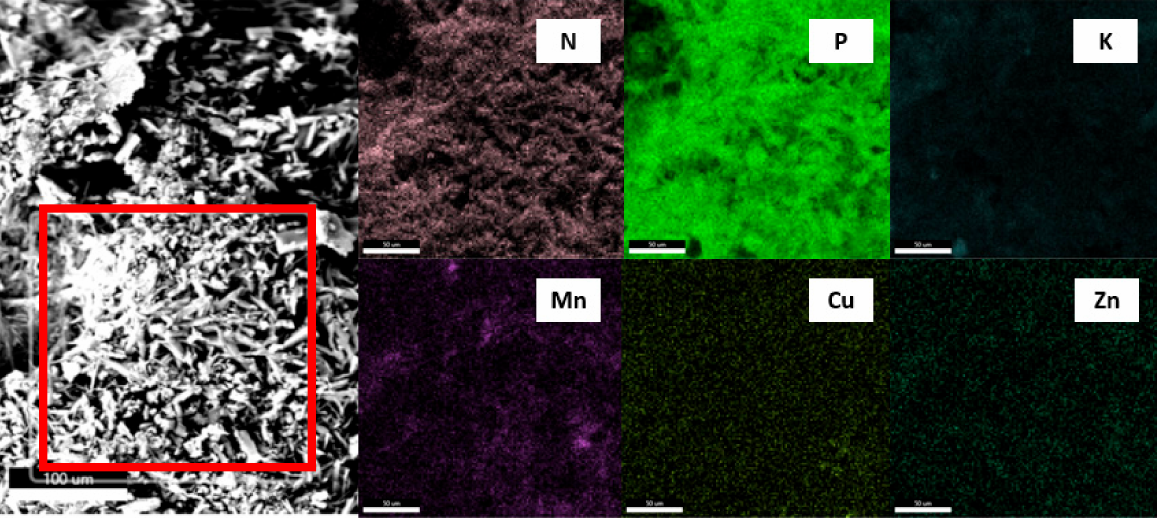
Figure 4. Sample surface mapping with ROI selected (area marked in red). Element map for